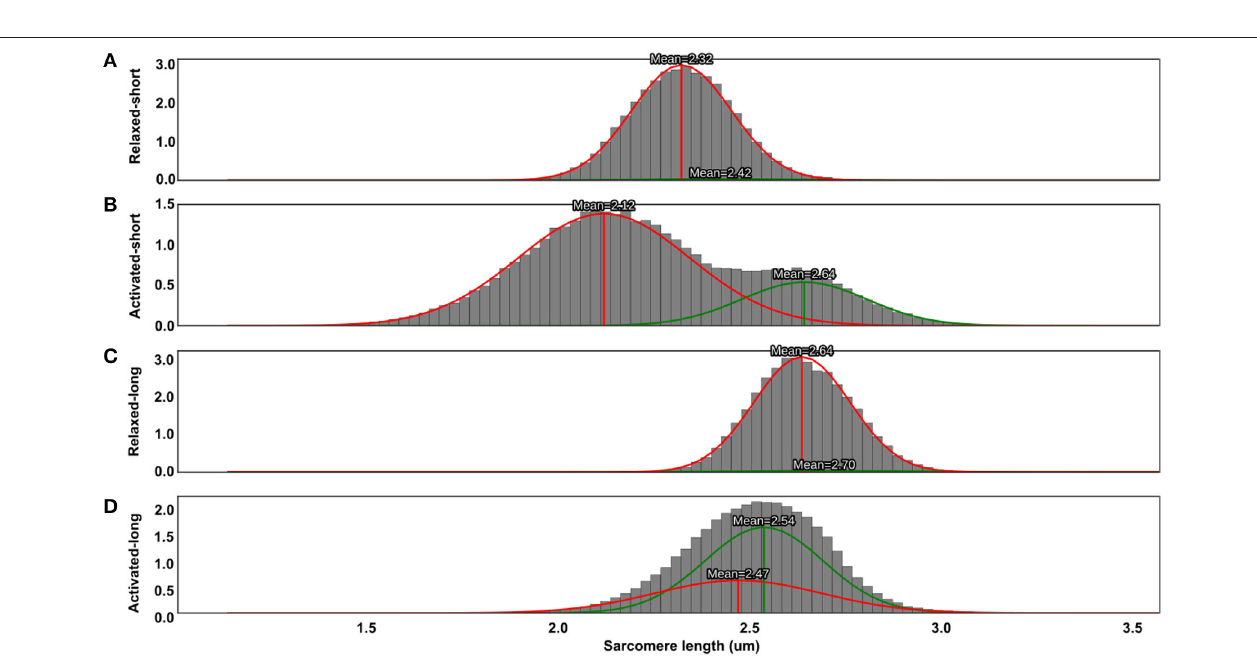
FIGURE 7 | Probability distribution functions (PDFs) of sarcomere lengths pooled from nine tested animals in the relaxed-short (A) , activated-short (B) , relaxed-long (C) , and activated-long (D) muscles. Two weighted Gaussian curves (red and green curves) were fitted to the PDFs. Sarcomere lengths in the relaxed muscles had a normal distribution and therefore had only one Gaussian curve with significant weight (A,C) . For the activated-short muscles, the distribution of SLs became bimodal, with mean lengths of 2.12 and 2.64 µ m (B) . However, a similar switch to bimodality in SL distribution was not observed in the activated-long muscle, as the SL distribution became only slightly positively skewed (D) . Note that the area under the PDF and the total area under the two weighted Gaussian curves are, respectively, equal to